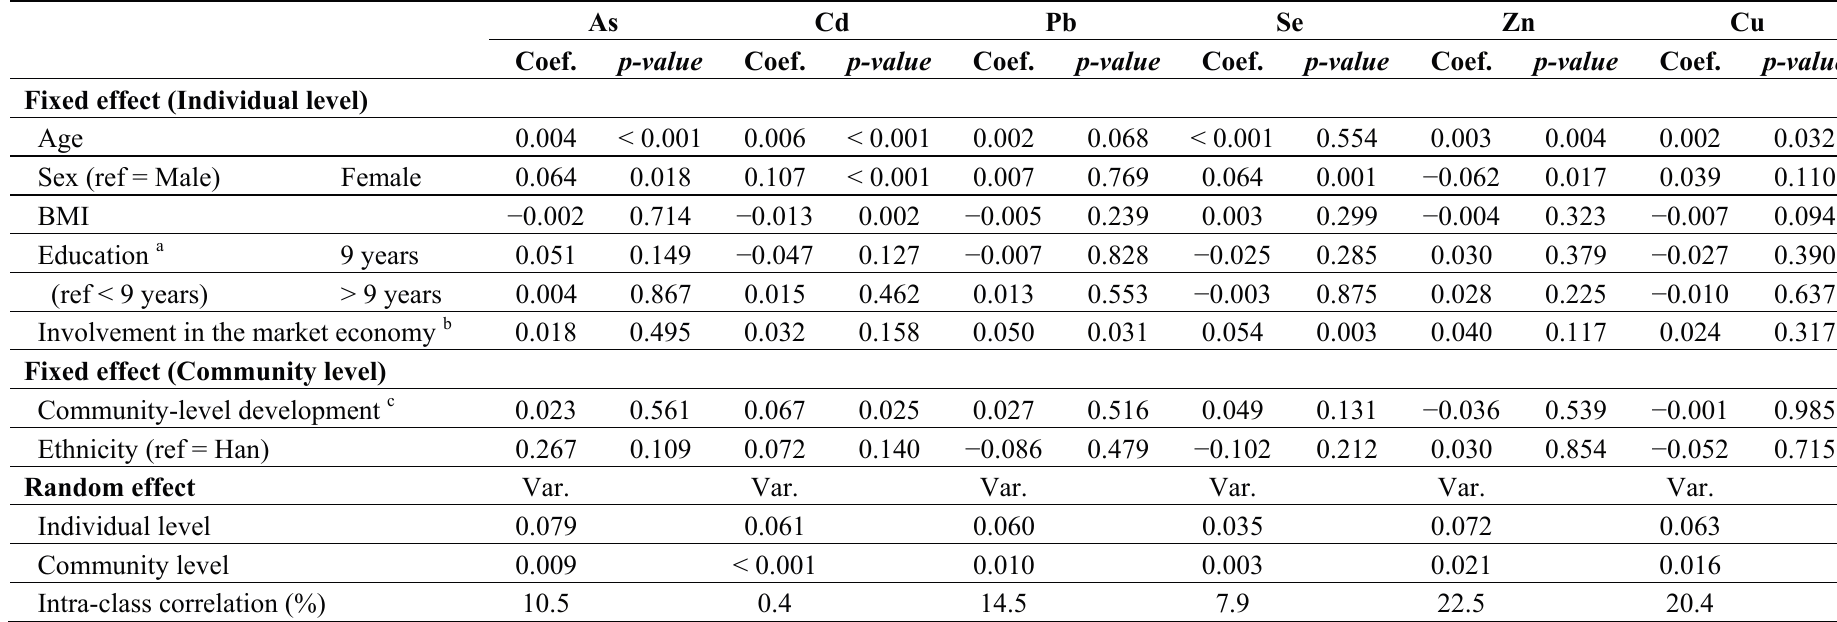
Table 4. The association between variation in element concentration and individual-level and community-level variables in Hainan Province, China (2008).